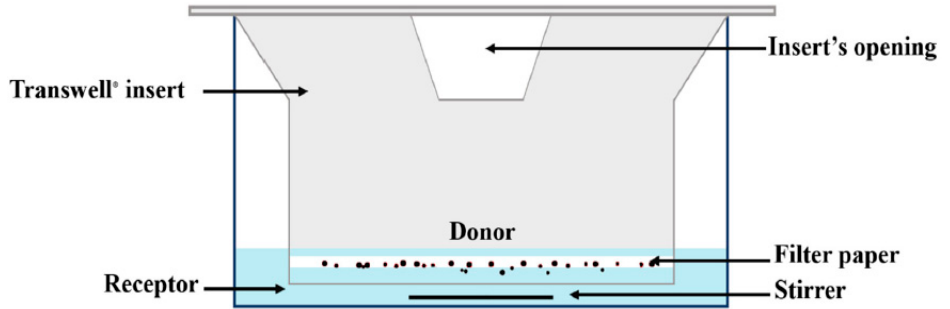
Figure 6. A schematic representation of the Transwell ® diffusion cell apparatus (The figure has been taken from reference [18]).